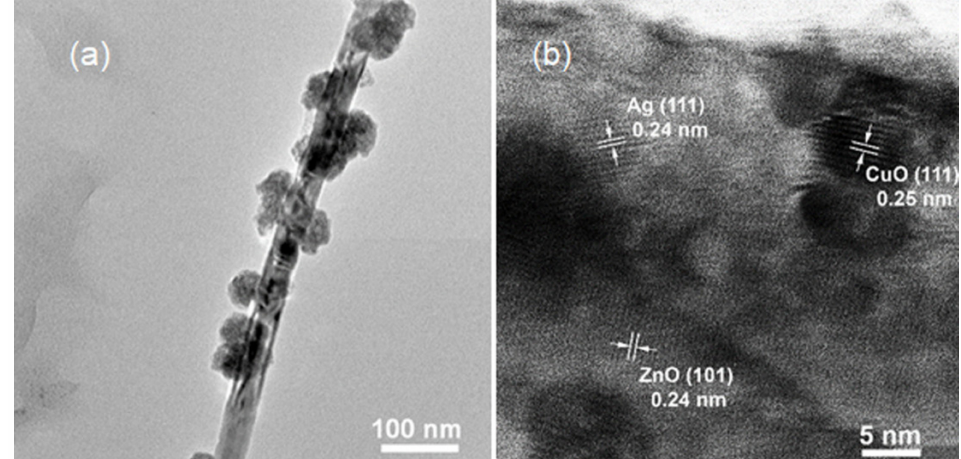
Figure 2. TEM ( a ) and HRTEM ( b ) images of CuO-Ag-ZnO